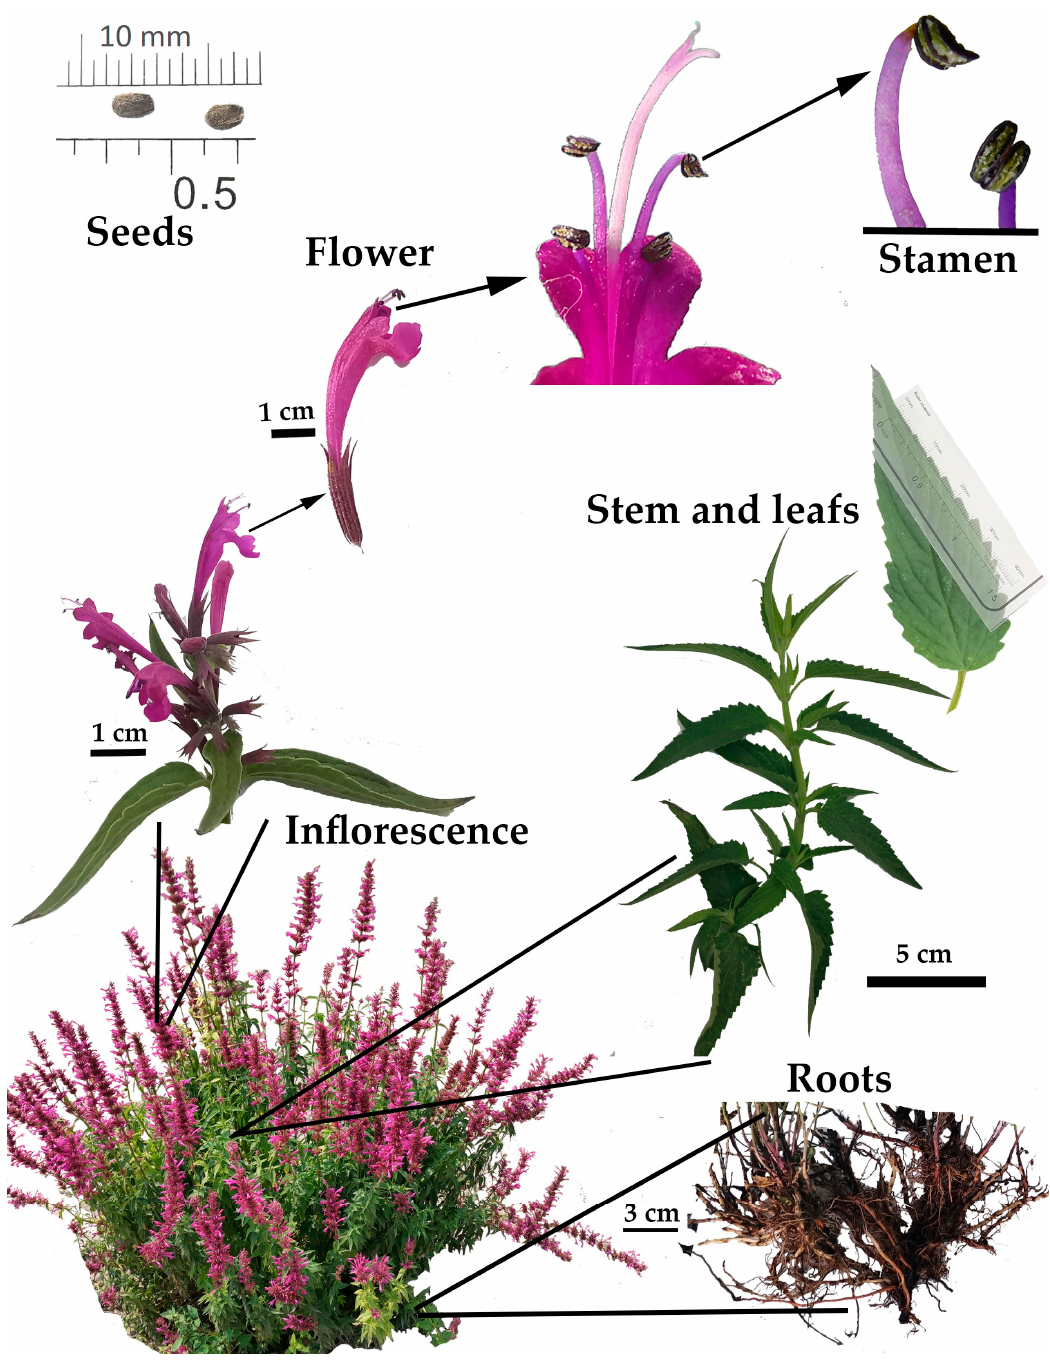
Figure 3. Plant biology of Agastache mexicana ssp. mexicana.